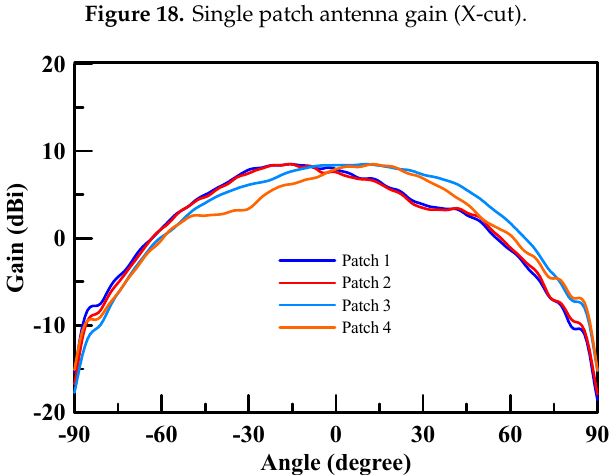
Figure 19. Single patch antenna gain (Y-cut).